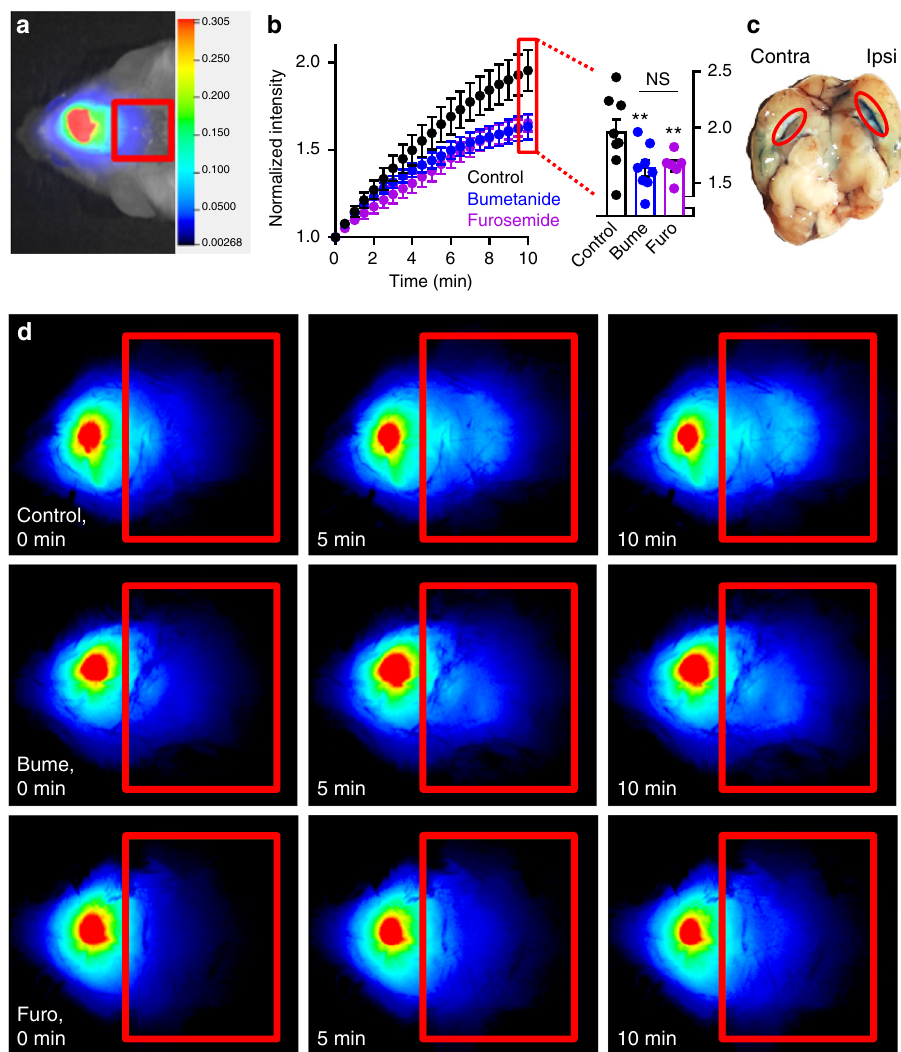
Fig. 6 Live imaging determines signi fi cant NKCC1 contribution to in vivo CSF production. a Illustration of pseudo-color fl uorescence superimposed on a white light image from a white mouse after ventricular injection of 10 μ M IRDye 800CW carboxylate dye. The dye content is quanti fi ed in the red box, placed in line with lambda. The intensity scale is arbitrary units and applies to all images. b Intensity of images were quanti fi ed and normalized to the fi rst image (0 min) for control (vehicle, black), bumetanide (blue), or furosemide (purple) and plotted as a function of time. Inset illustrates summarized data at the 10-min time point; the fl uorescence intensity of control mice reached 1.95 ± 0.12 ( n = 8 mice), furosemide-treated 1.65 ± 0.05 (n = 6 mice), and bumetanide 1.63 ± 0.07 ( n = 8 mice). c Unilateral injection of Evans Blue revealed staining mainly in the injected, right lateral ventricle (red oval) compared to the contralateral ventricle. d Representative images at 0, 5, and 10 min for control condition (top panels), bumetanide treatment (middle panels), and furosemide treatment (bottom panels). Error bars represent standard error of the mean and statistical signi fi cance was evaluated with two-way ANOVA (RM) followed by Tukey ’ s multiple comparisons test. Asterisks above the bars indicate comparison to control while comparisons between test solutions are indicated with a line above the respective bars. ** P < 0.01, NS: not signi fi cant ( P = fl uorescence intensity recorded in the area of interest was nor- malized to the intensity of the fi rst image, summarized, and illu- strated as a function of time (Fig. 6b). Inclusion of bumetanide (100 μ M, n = 8, two-way analysis of variance (ANOVA) (repeated measures (RM)) followed by Tukey ’ s multiple comparisons test, P = 0.0018, df = 399, q = 4.9) or furosemide (2 mM, n = 6, two-way ANOVA (RM) followed by Tukey ’ s multiple comparisons test, P = 0.0083, df = 399, q = 4.2) signi fi cantly decreased the movement